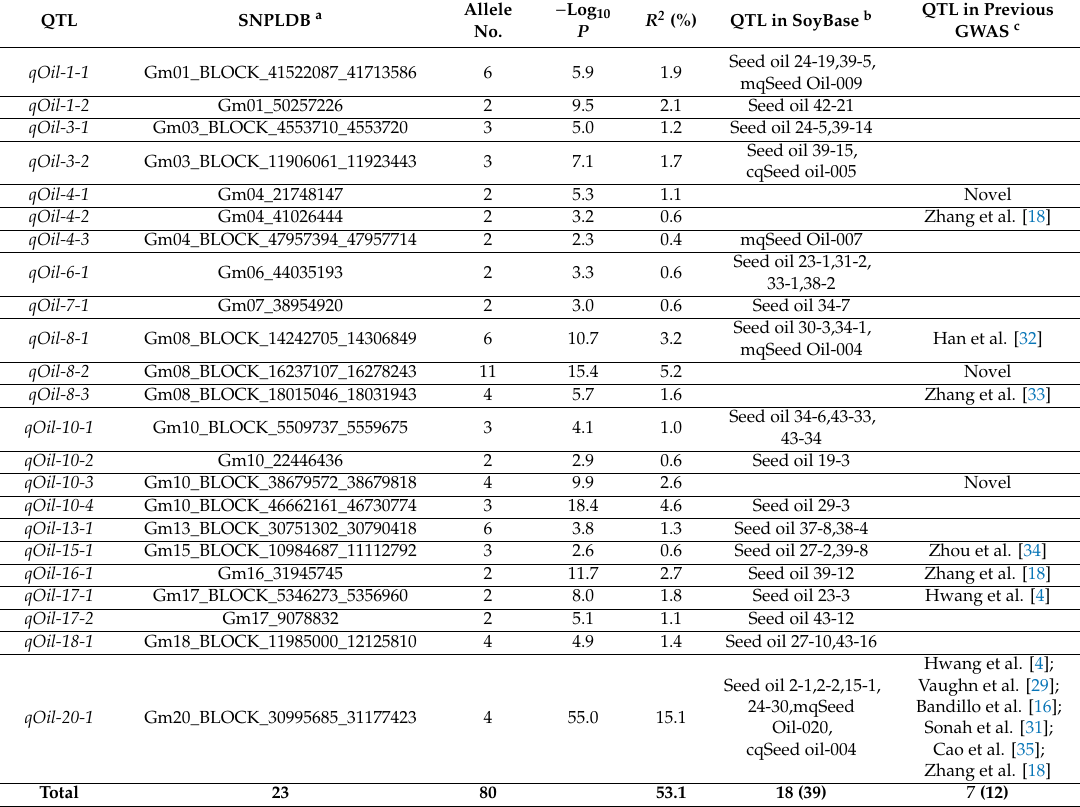
Table 3. QTLs associated with the seed oil content detected in the soybean association panel.